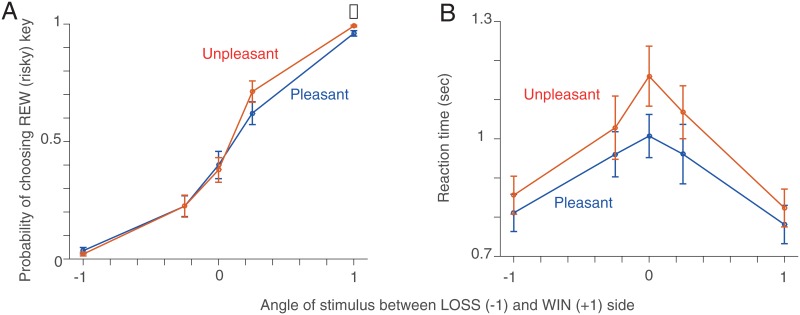
Model-agnostic results (Session 1).A. Probability of choosing the REW (risky) key in Session 1. The red (blue) line indicates the mean and the SEM of the probability of choosing the REW key in the Unpleasant (Pleasant) condition. When the stimulus strongly leaned toward the WIN side (s = 1), the difference between Pleasant and Unpleasant Room participants was mildly significant. B. Reaction time (RT). Both groups showed significant dependence of RT on stimulus ambiguity.